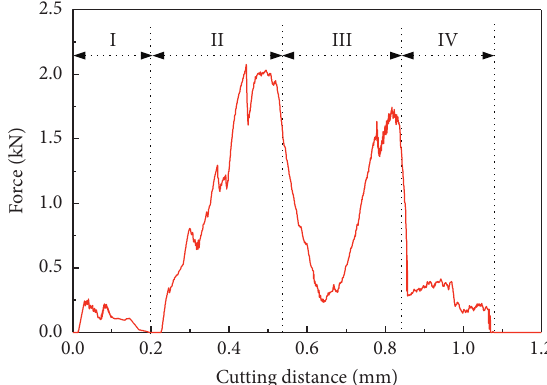
Figure 6: Variation on cutting force with cutting distance.